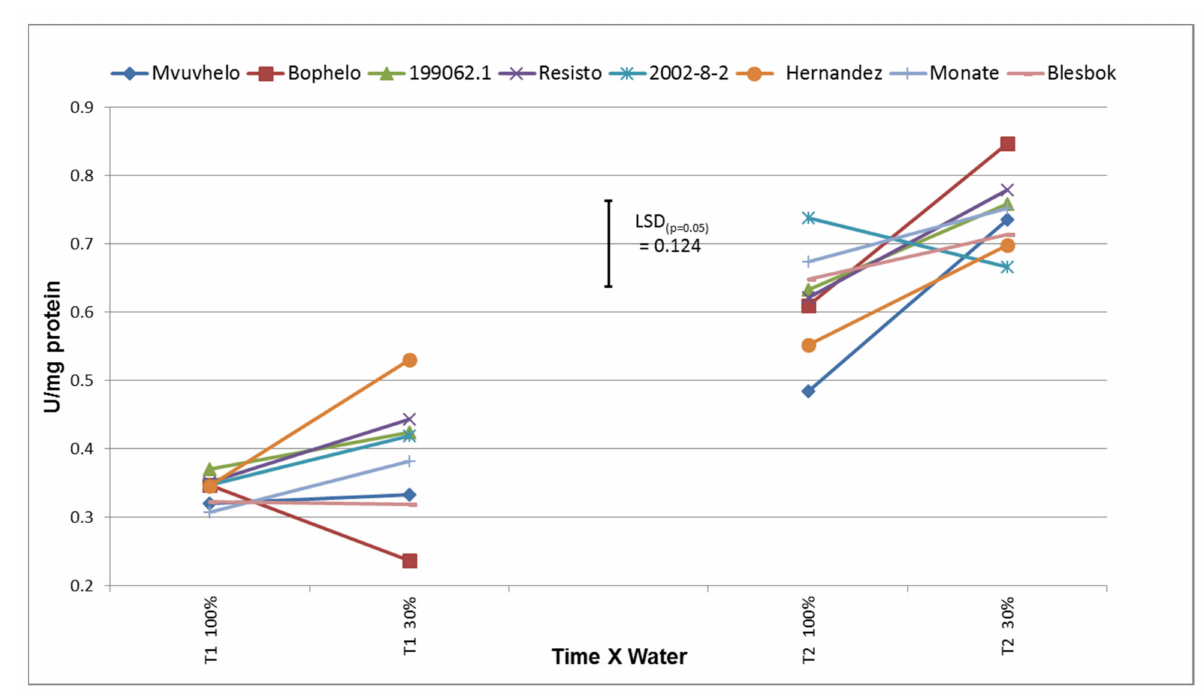
Figure 3. Activity levels of the superoxide dismutase (SOD) enzyme in the leaves of eight sweet potato cultivars and lines subjected to control and drought stress conditions. LSD after planting; T2 = 120 days after planting; 100% = control treatment; 30% = severe stress treatment.